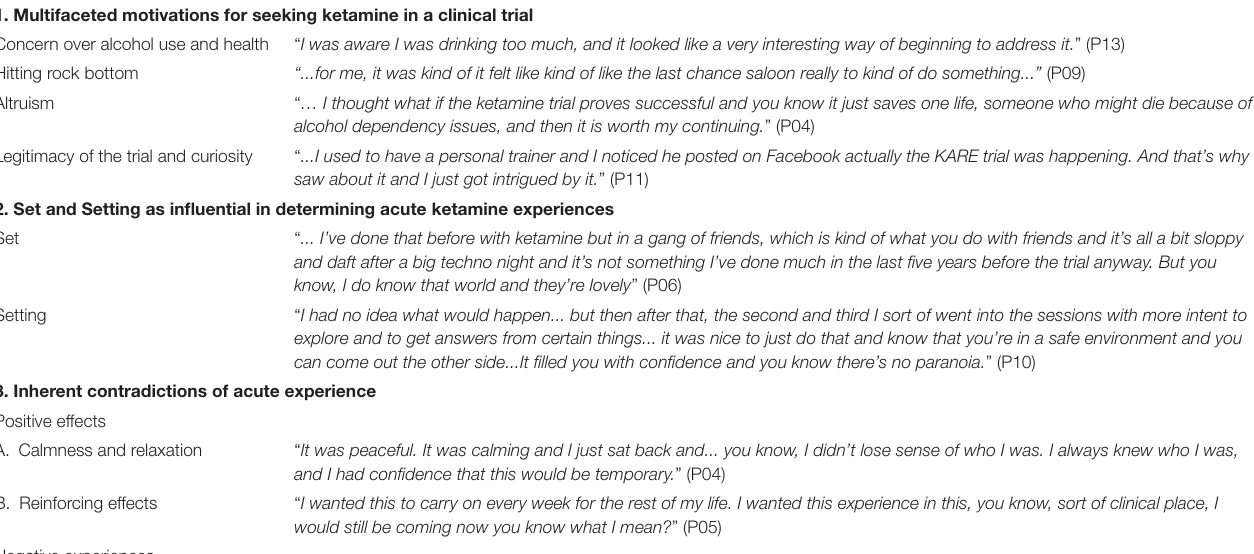
TABLE 2 | Themes, codes, example